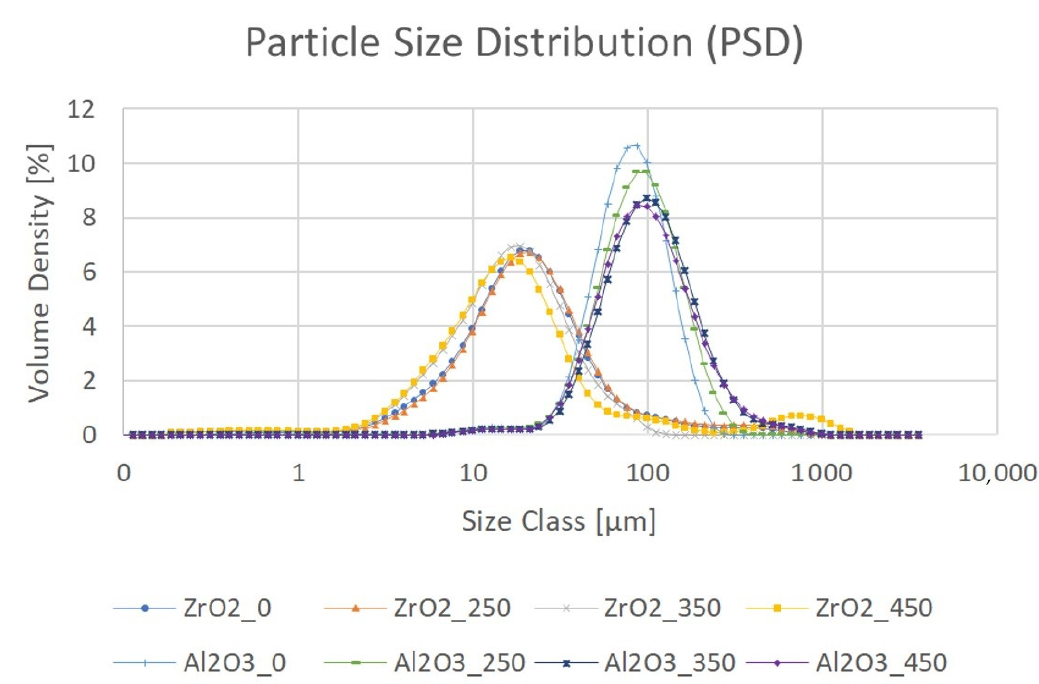
Figure 8. PSD of APTES-modified ZrO 2 and Al 2 O 3 powders. Table 3. PSD of the APTES-modified ZrO 2 powders.